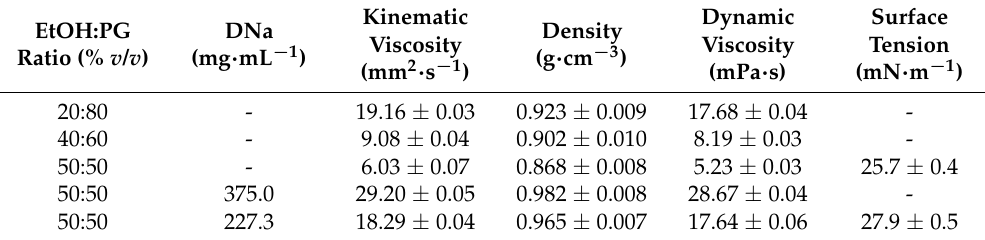
Table 2. Viscosity values of the liquid inks.